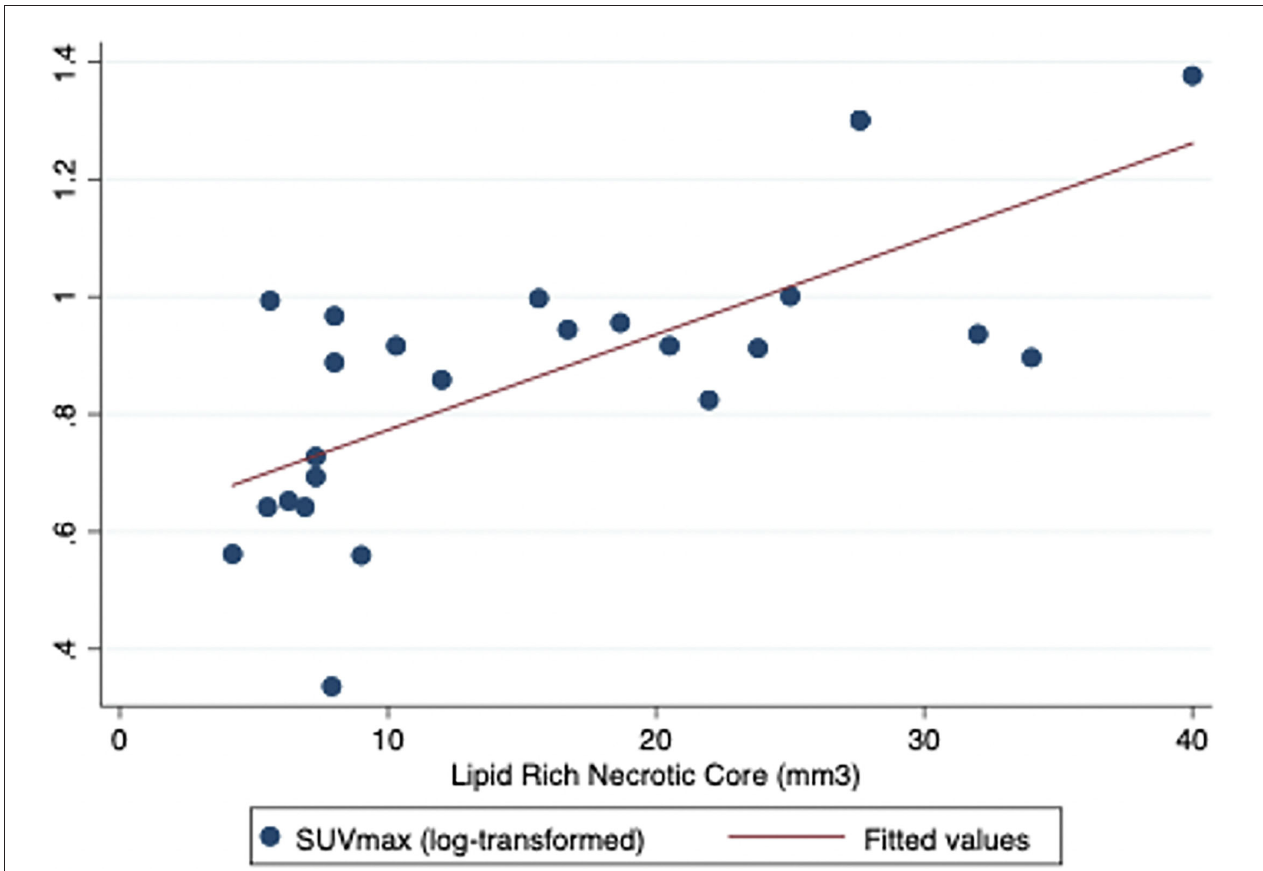
FIGURE 2 | Regression analysis figure for LRNC and SUV max